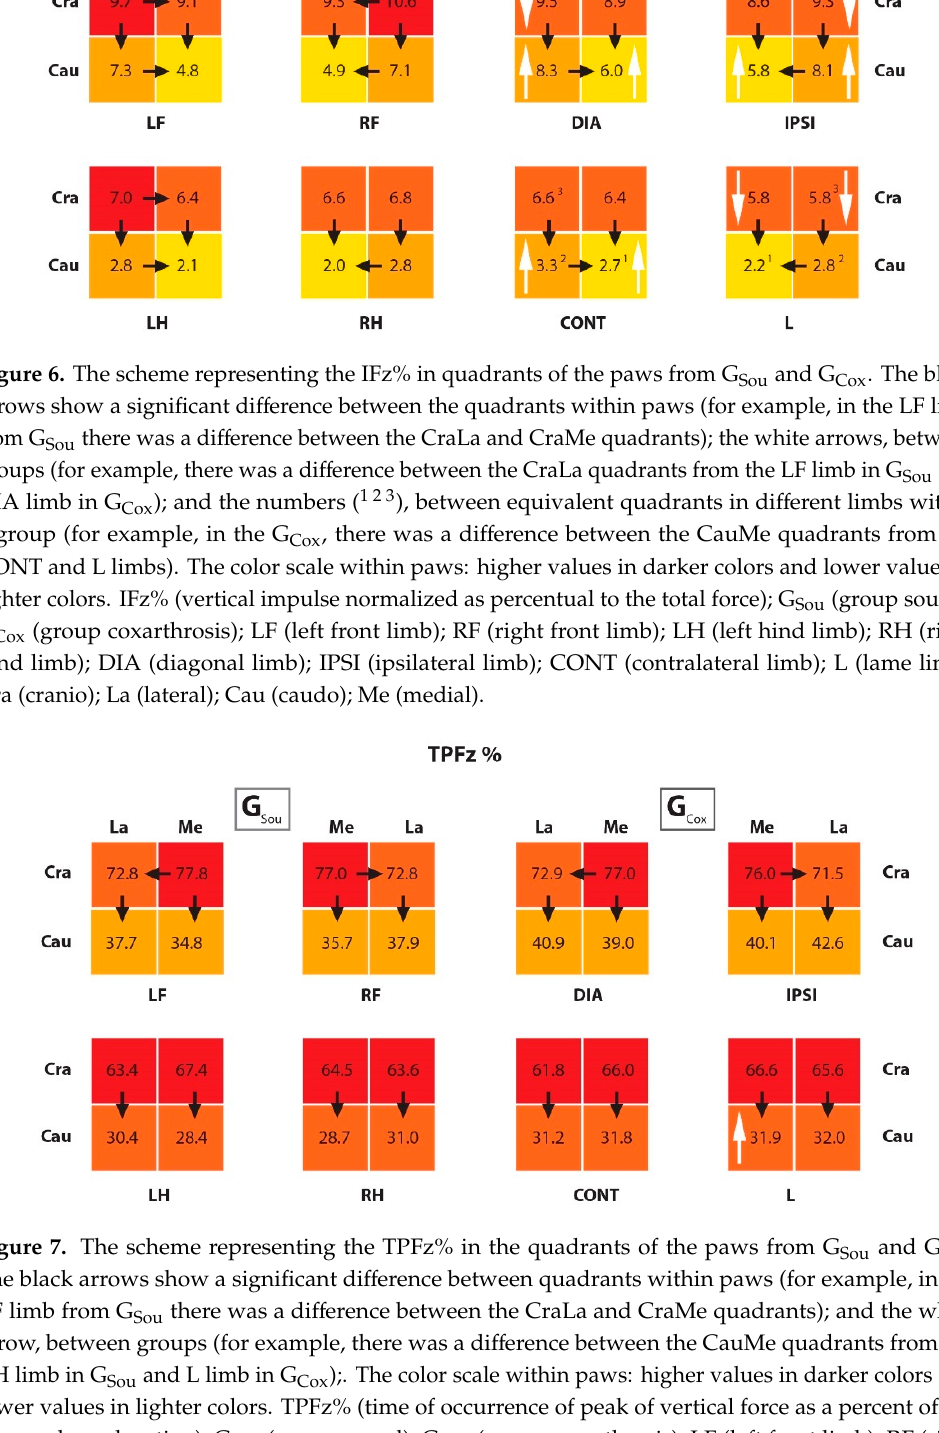
Table 7. The p values for PFz%, IFz%, and TPFz% comparing the quadrants CraLa, CraMe, CauLa, and CauMe of the IPSI (RF), DIA (LF), CONT (LH), L (RH) limbs between G Sou and G Cox . Limbs Quadrants PFz% IFz% TPFz% CraLa 0.10 0.01 0.75 CraMe 0.55 0.12 Ipsilateral (RF)